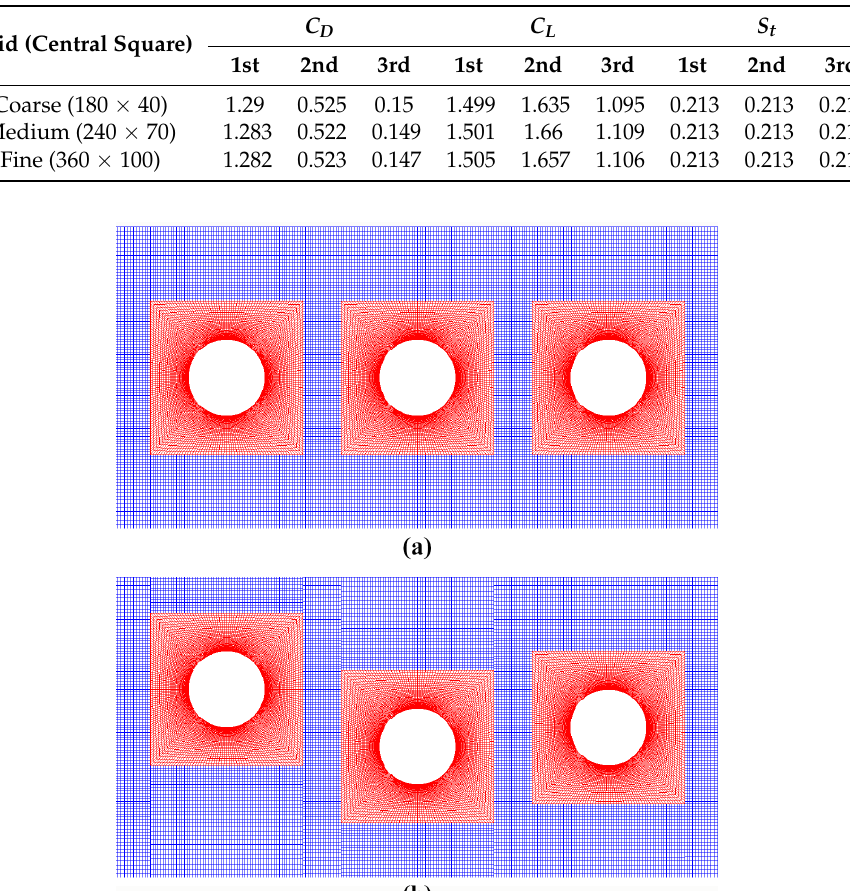
Table 2. Grid resolution study ( Re = 3 × 10 4 ).